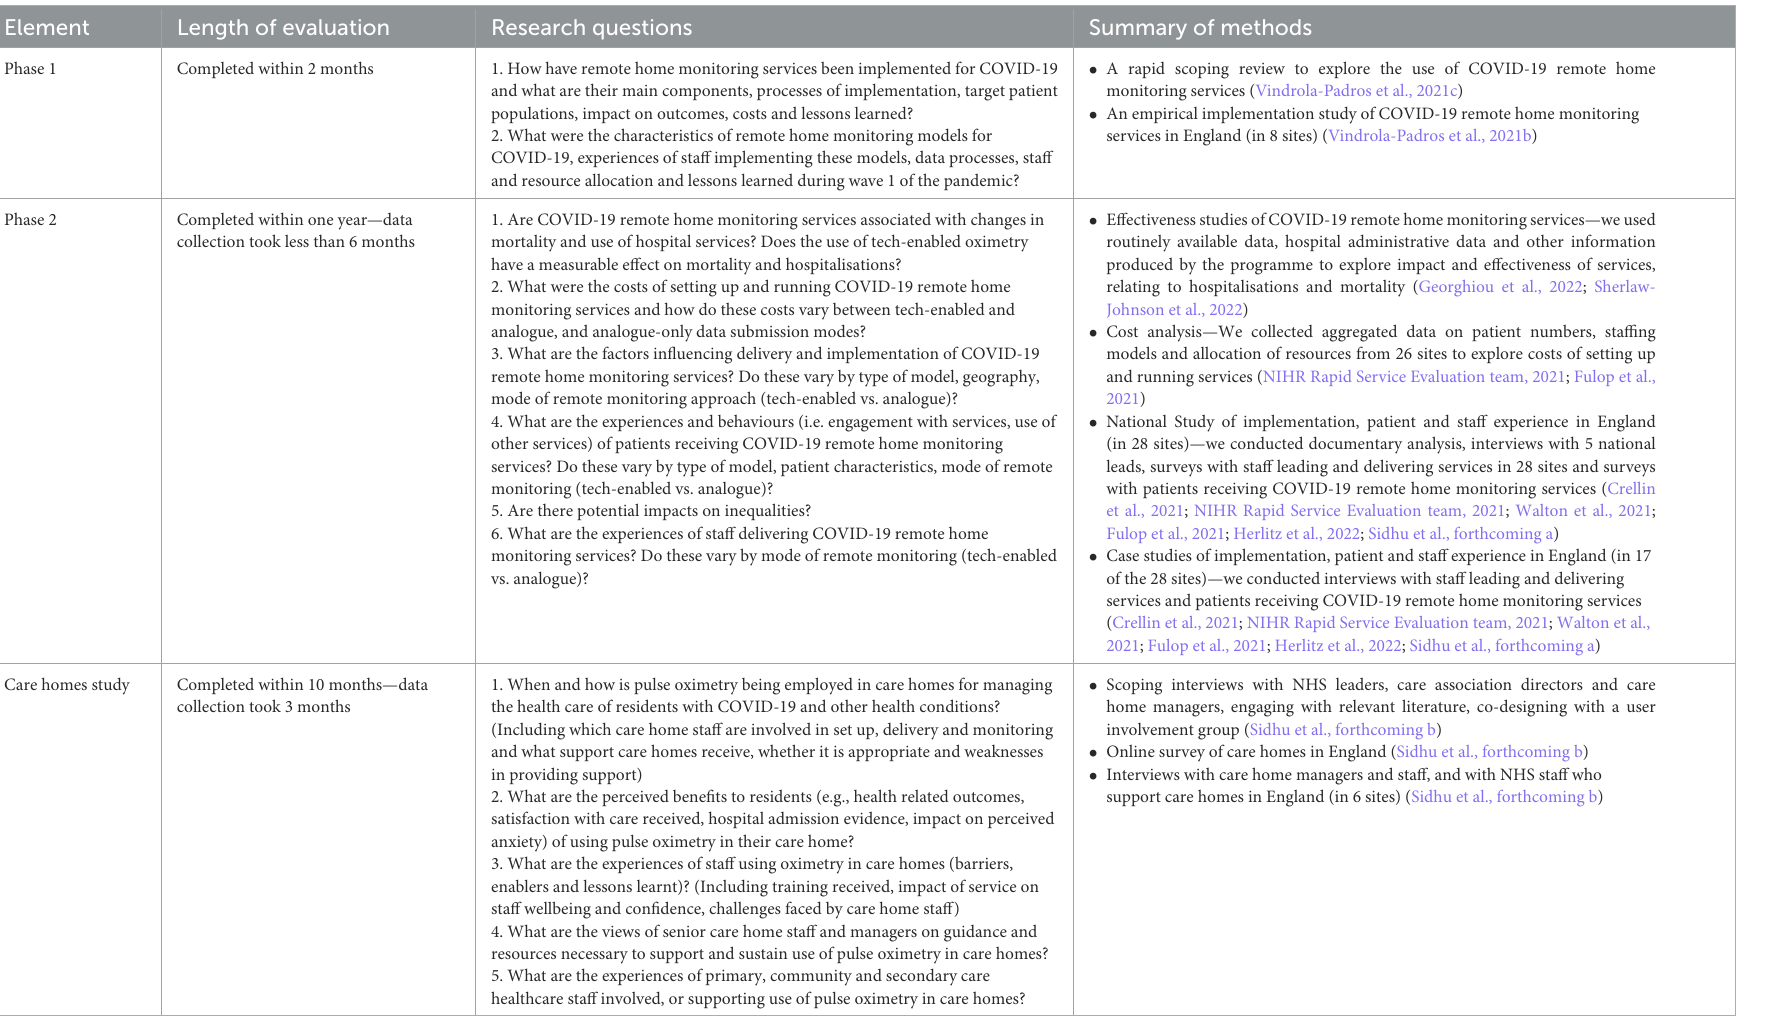
TABLE 1 Research questions and a summary of methods for each rapid evaluation